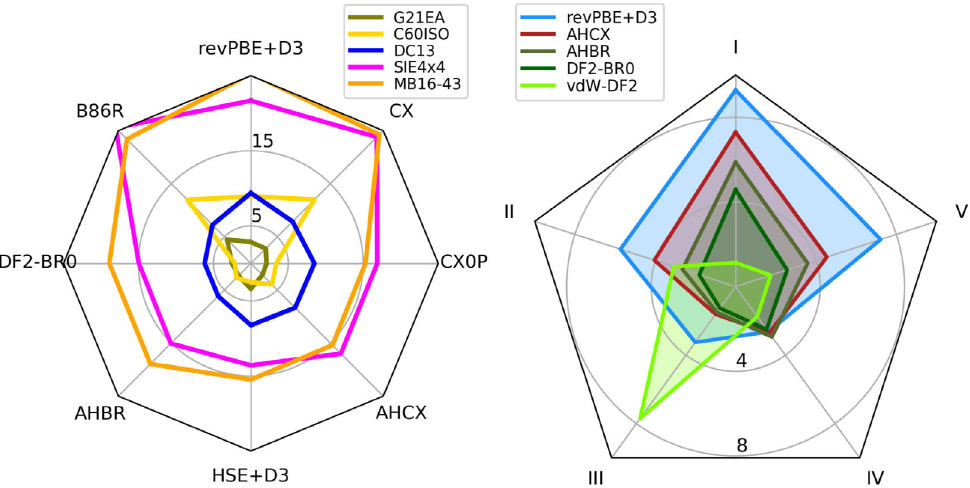
FIG. 7. Drivers for XC development in the GMTKN55 suite of benchmarks [69]. Performance of vdW-DF-based hybrids on traditional molecular challenges (identified in left panel) and on what we consider key transition-state challenges (right panel) in benchmark set PX13 (I), BHPERI (II), IDISP (III), WATER27 (IV), and WCPT18 (V). Self-interaction errors play an essential role not only in the SIE4x4 set but also in G21EA (WATER27) due to the presence of negative ions and radicals [89] requiring an electrostatic- environment approach for reliable assessments (see Appendix B). The traditional challenges include the so-called “ difficult-for-DFT ” (DC13) and “ mindless benchmarking ” (MB16-43) sets, as well as fullerene isomerization problems (collected in benchmark set C60ISO).